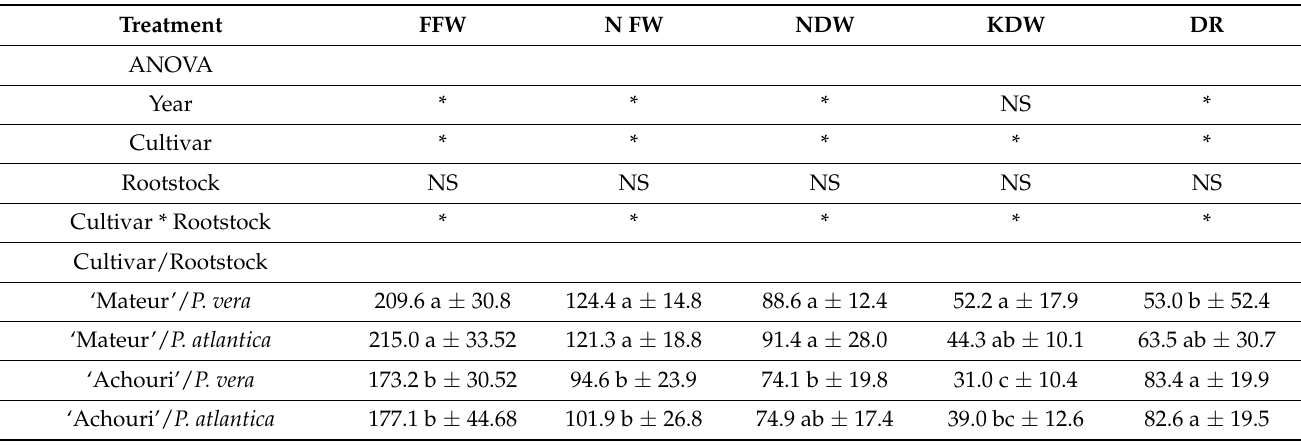
Table 2. Mean weights (g) of fresh fruit (FFW) and nut (NFW), dry weights of nut (NDW) and kernel (KDW), and nut dehiscence rate (DR) in percent (%).